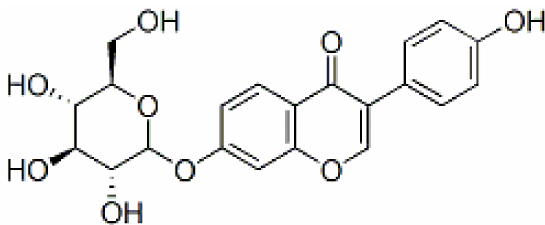
Figure 11. The chemical structure of